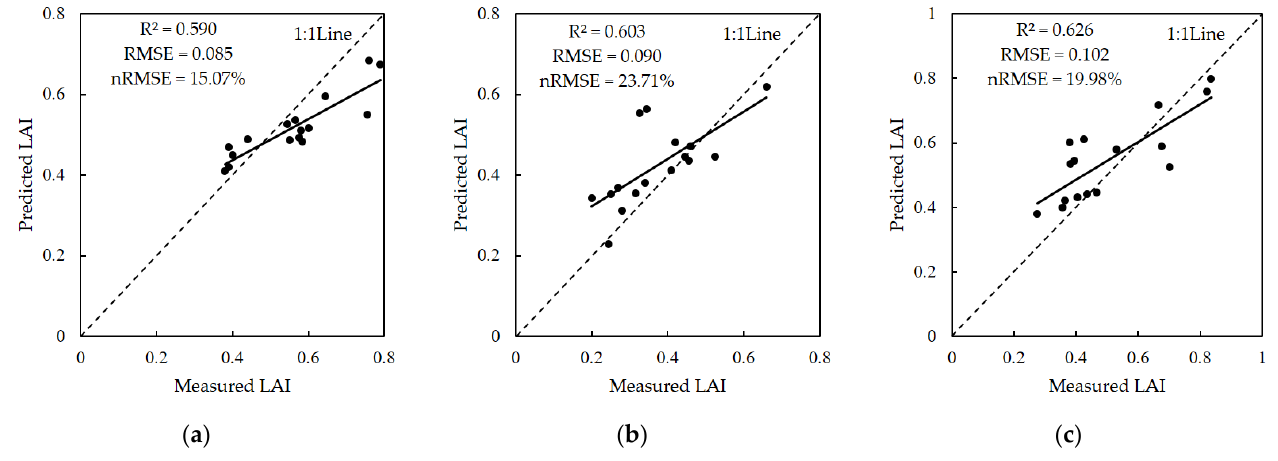
Figure 5. Validation results of single-factor model for kiwifruit LAI in each growth stage. ( a ) Initial flowering stage (IF); ( b ) young fruit stage (YF); ( c ) fruit enlargement stage (FE). Table 6. Comparison of SWR and RFR analyses for spectral parameters in each growth